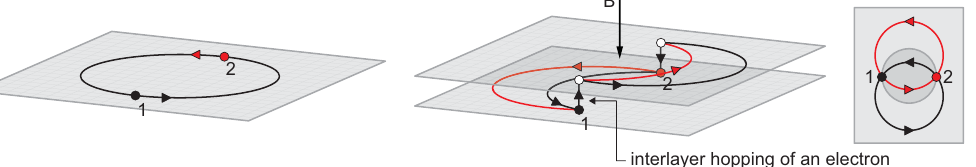
Figure 4. When electrons can hop between two sheets, as in bilayer graphene, the topology of the single-loop interchange of particles may change: both particles can hop between sheets and may be in opposite layers when they traverse their own orbits (centre). In this case, particles may not conserve their mutual distance. This results in leakage of flux of the cyclotron orbit and a smaller-than-nominal orbit (left) that can match particles that lie closer together (right).